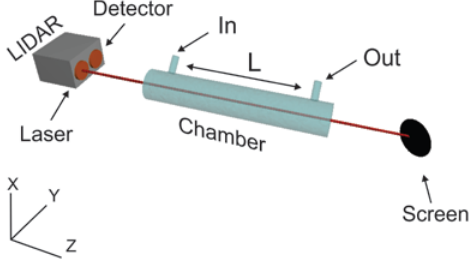
Figure 1. Schematic view of the experiment.